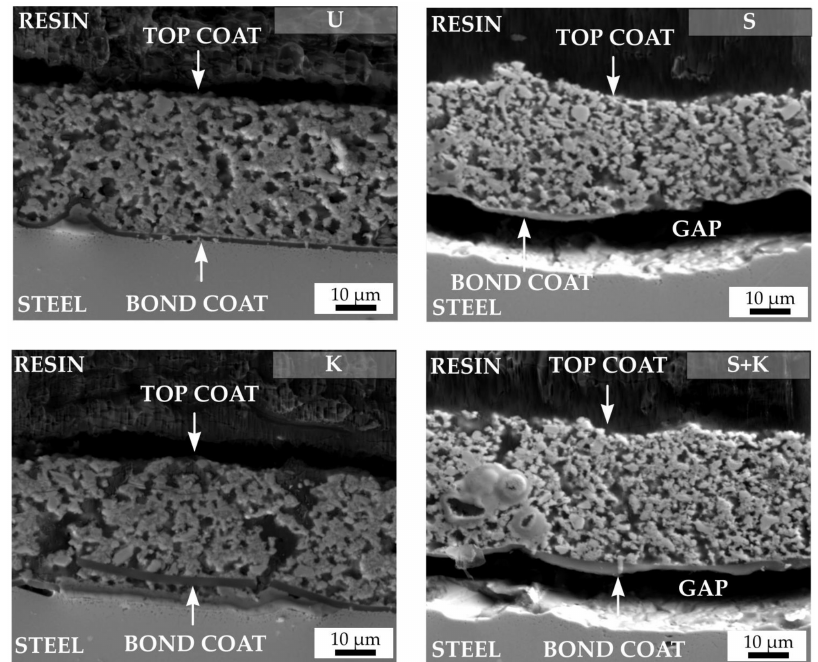
Figure 11. Cross sections of C2c coatings after oxidation tests. The applied cleaning procedure is indicated by the abbreviation in the upper right corner of each figure (U – ultrasonic cleaning, K – chemical etching with Kroll’s reagent, S – sandblasting, S + K – sandblasting + chemical etching with Kroll’s